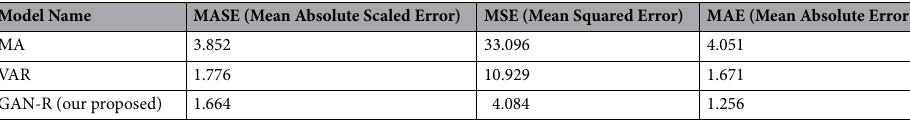
Table 2. The above table shows the result of statistical